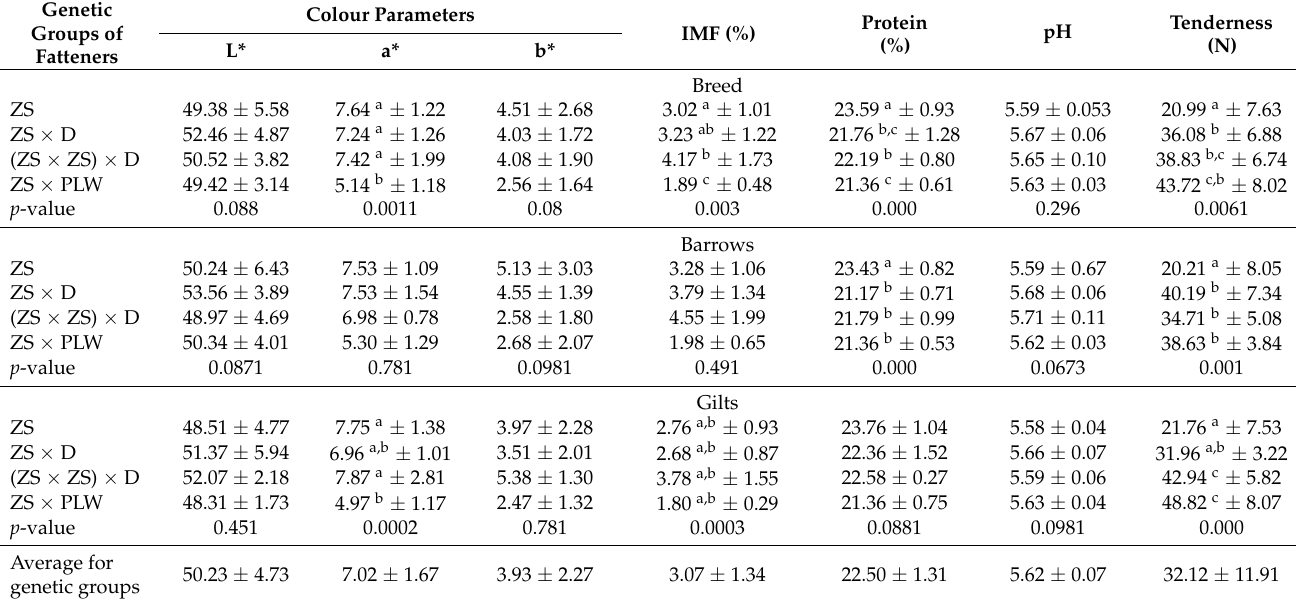
Table 7. Quality characteristics of the raw smoked loin ( x , ±